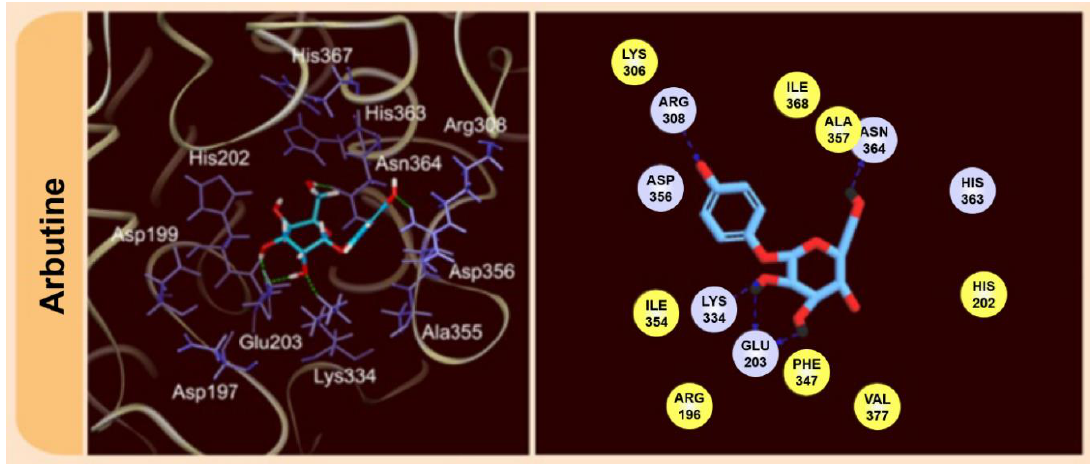
Figure 2. Molecular interactions of arbutin with tyrosinase based on Molecular Dynamics Molecular interactions of arbutin with tyrosinase based on Molecular Dynamics computations [11]. Reprinted with permission from ref. [11]. Copyright 2015 Springer. computations [11]. Reprinted with permission from ref. [11]. Copyright 2015